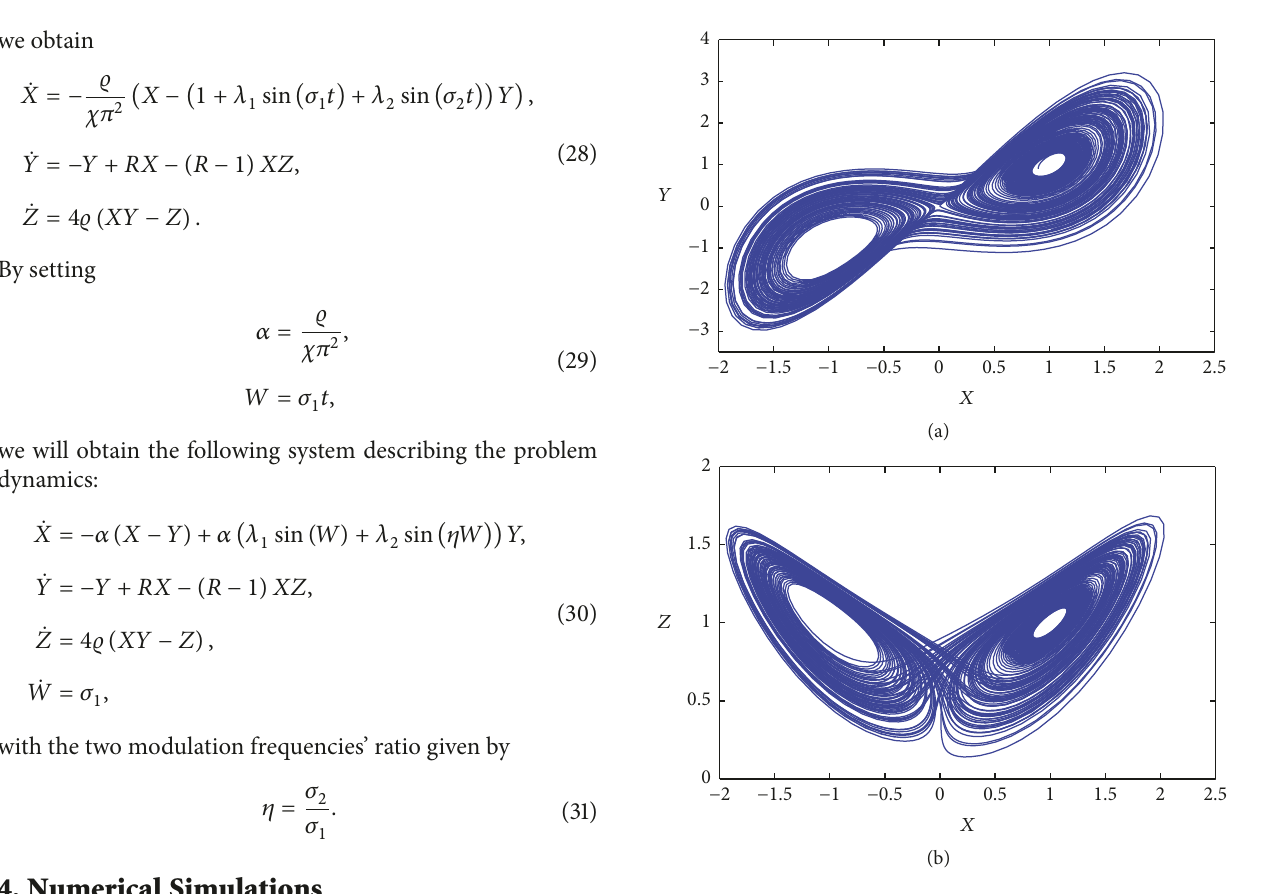
Figure 2: The solution on a phase diagram for 𝛼 = 5 , 𝑅 = 25 , 𝜎 1 = 0 , and 𝜂 = 0 . 𝑌 versus 𝑋 (a) and 𝑍 versus 𝑋